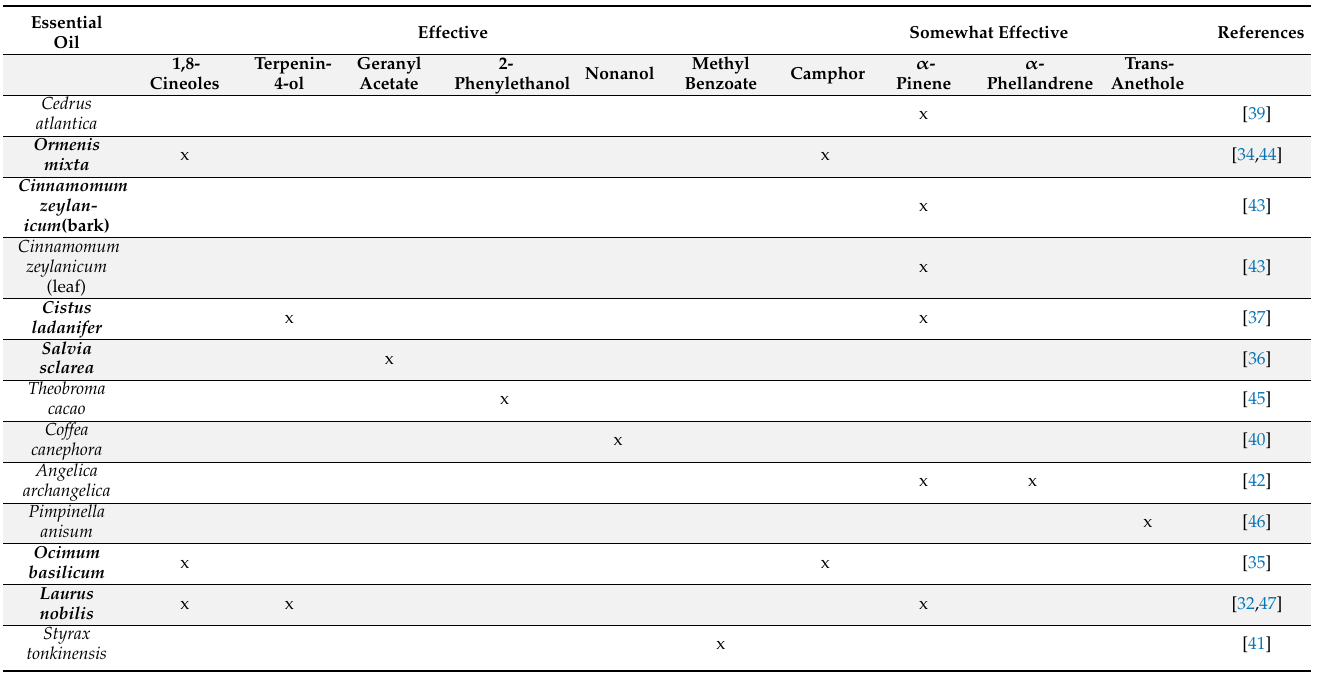
Table 4. Presence of effective and somewhat effective sprout suppressant compounds as defined by Boivin et al. [1] previously reported in the EOs used in this study. EOs in bold resulted in significant differences in tuber sprouting from the